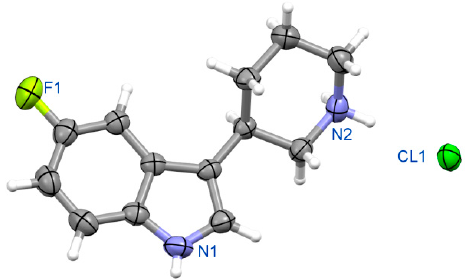
Figure 12. View of molecular structure of enantiomeric fluoro- derivative (R)-10b